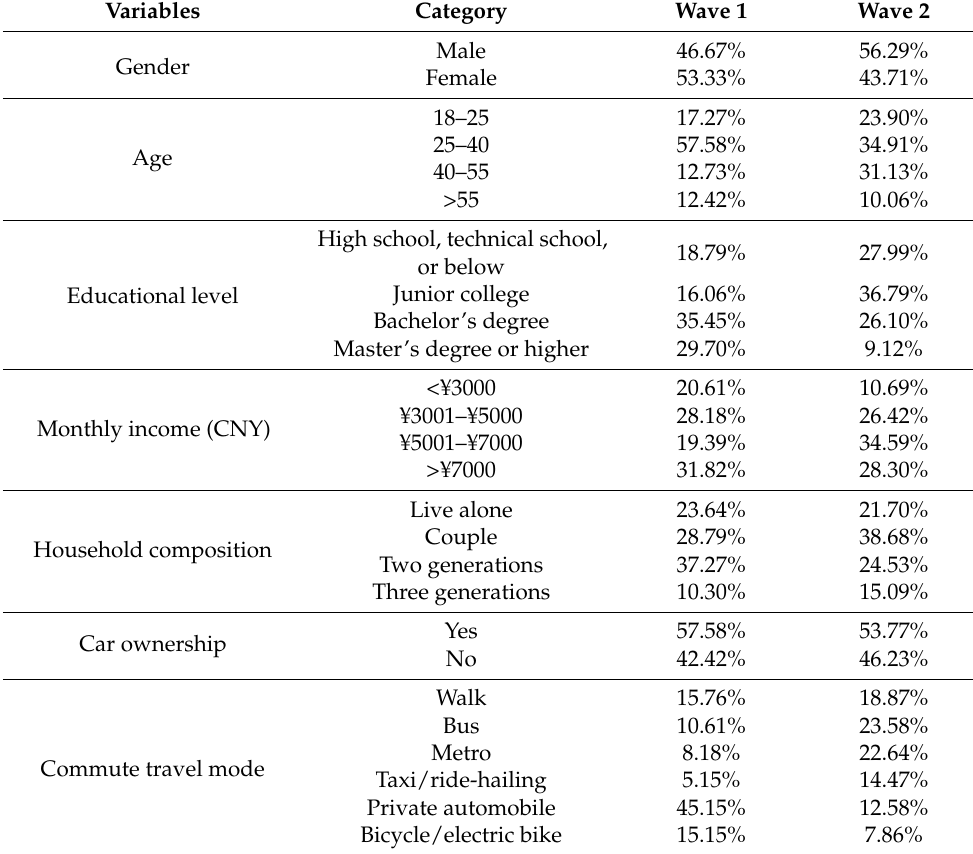
Figure 3. The factors regarding travel mode choice in the pilot survey. Table 2. Descriptive statistics of the socio-demographic Table 1. Model variables.